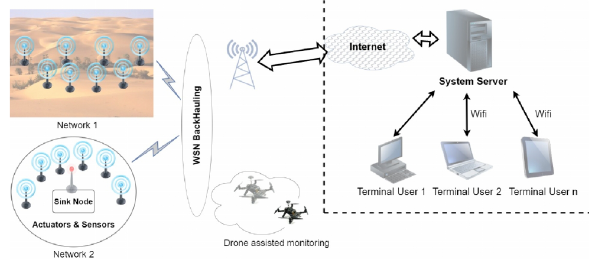
Figure 5 . Deploying WSN as bottom level in IoT architecture for Environment Monitoring (extended version based on (Xu et al. 2019)).